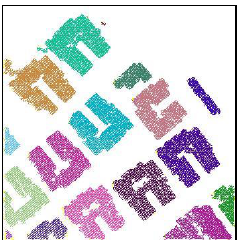
Figure 6: result of isolation of each